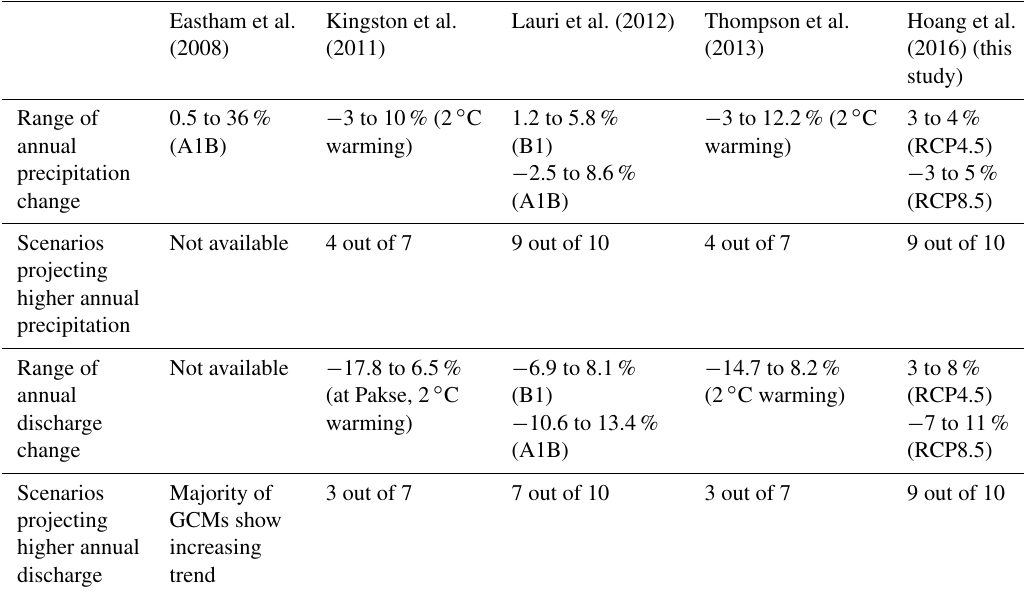
Table 4. Comparing projected precipitation and discharge changes across